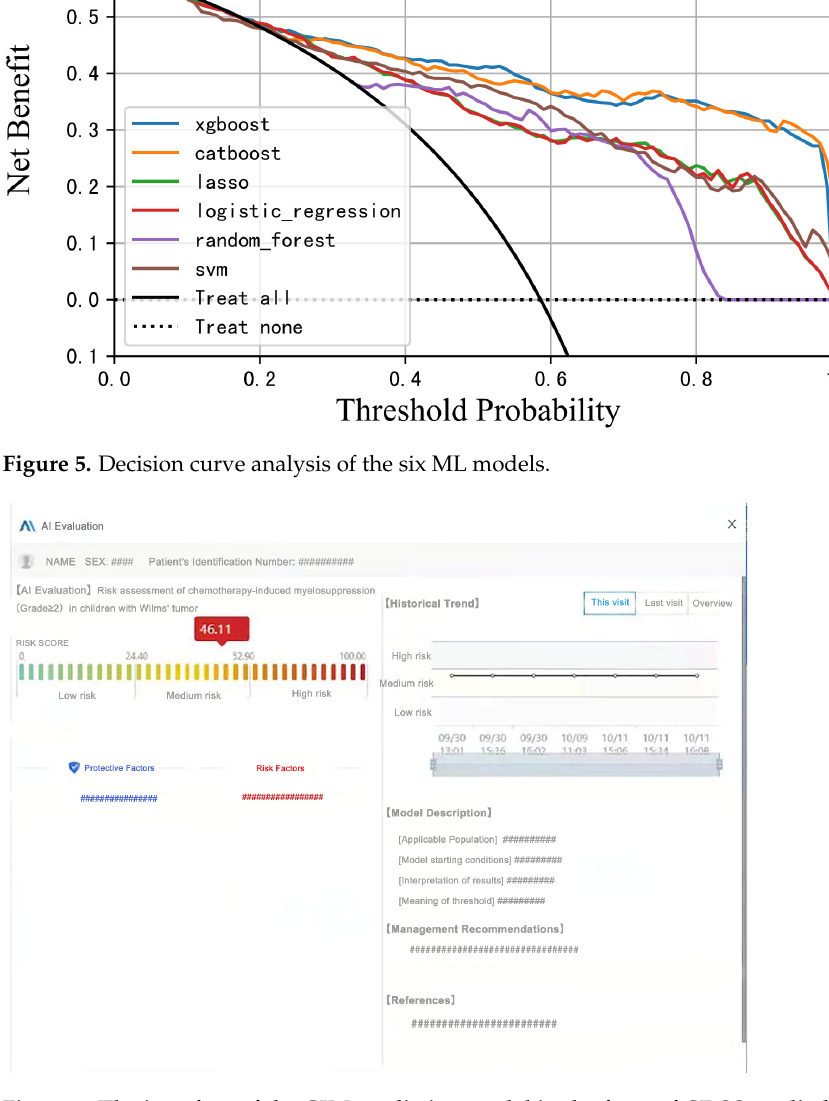
Figure 6. The interface of the CIM prediction model in the form of CDSS applied in our hospital HIS. AI Evaluation: the “AI Evaluation” module shows the risk scores of patients with grade ≥ 2 CIM calculated by the model, with the corresponding “protective factors” and “risk factors” listed below. Historical Trend: the “Historical Trends” module records the occurrence of CIM in previous chemotherapy cycles. Model Description: this module provides a detailed description of the appli- cable conditions and the model results. Management Recommendations: according to the predic-